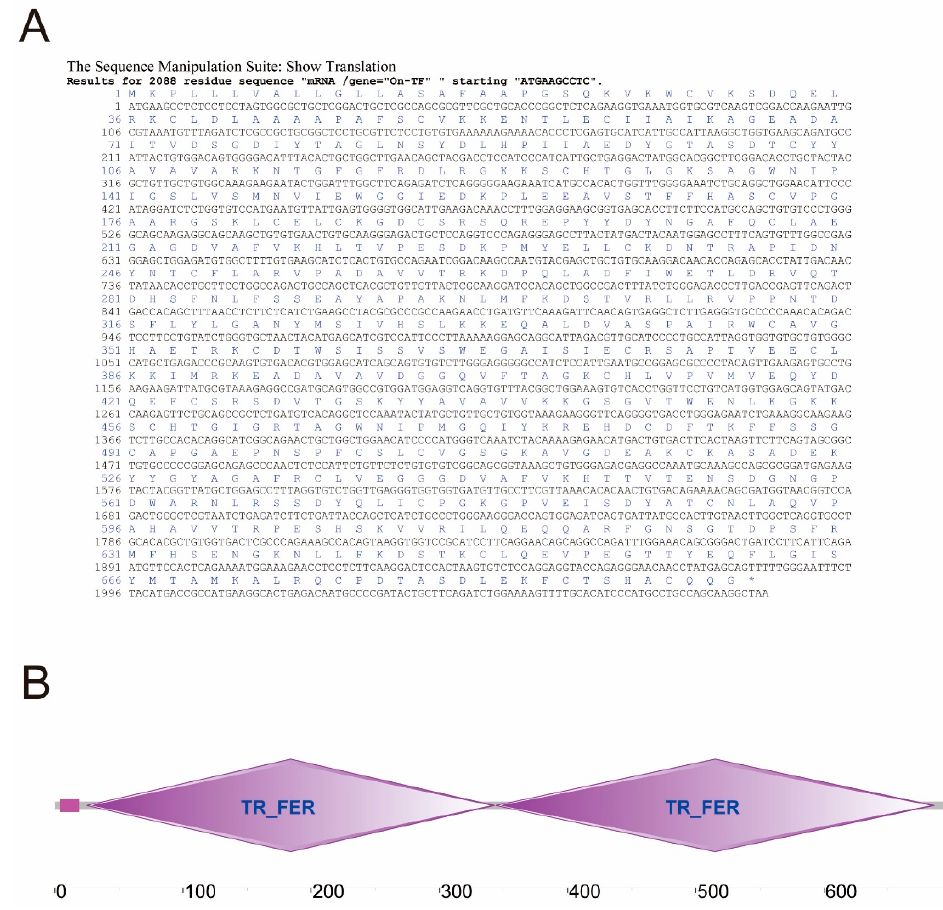
Figure 2. Full-length nucleotide sequences and deduced amino acid sequences of On-TF ( A ) and structure diagram of On-TF ( B ). Note: Asterisk indicates the stop codon ( A ). The TR_FER conserved domain is denoted by pink rhombus ( B ).